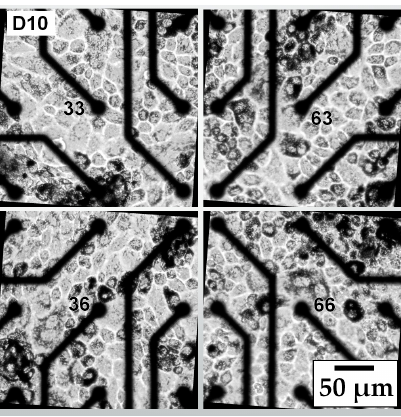
Figure 1. A selection of microscope images (magnification X20) taken at day 10. Electrodes diameter is 10 μ